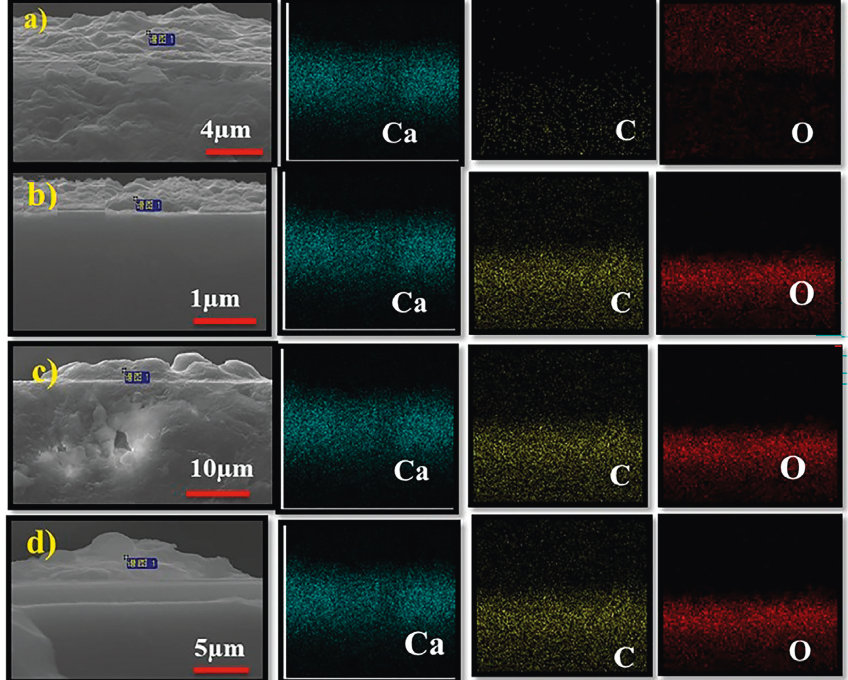
Figure 3: SEM and EDX analysis of (PAH/PAMAM) 7.5 -CaCO 3 composite. Elemental mapping of calcium, carbon, and oxygen from all the components on the cross section multilayers of (a) noncross-linked, (b) low cross-linked, (c) medium cross-linked, and (d) highly cross- linked films.